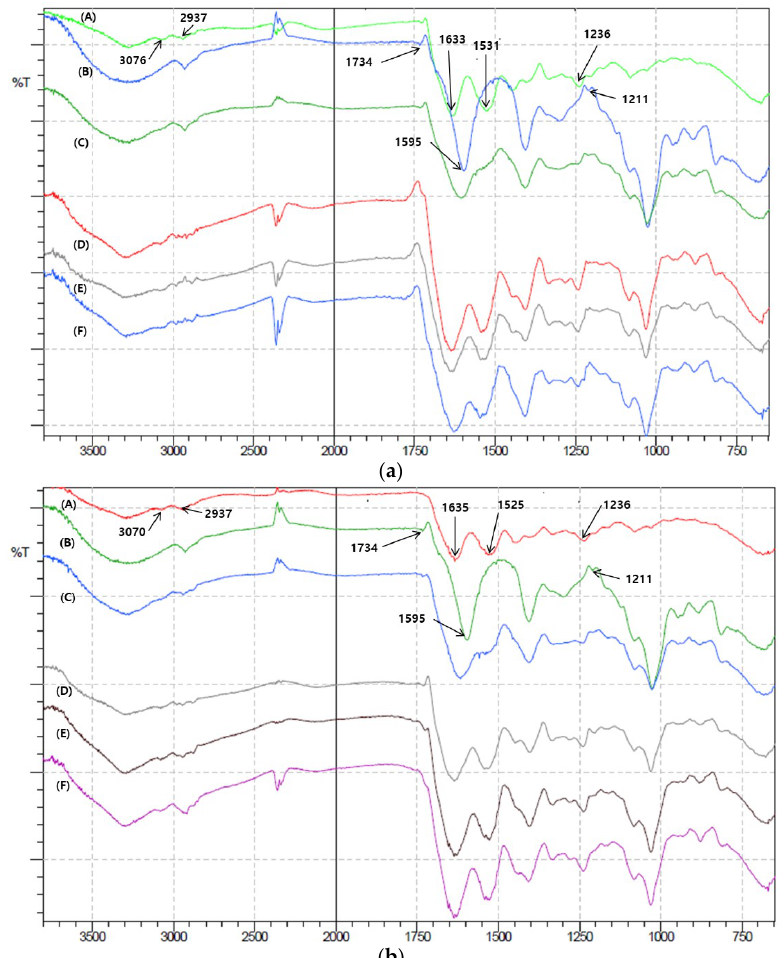
Figure 2. ATR-FTIR of various samples. ( a ) (A) Powder HWGA, (B) powder SA, (C) physical mixture of powder HWGA and SA (1:0.4), (D) freeze-dried HWGA-SA (1:0.4) solution, (E) freeze-dried HWGA-SA (1:0.4) coacervates, (F) freeze-dried HWGA-SA (1:0.4) precipitates. ( b ) (A) Powder LWGA, (B) powder SA, (C) physical mixture of powder LWGA and SA, (D) freeze-dried LWGA-SA (1:0.4) solution, (E) freeze-dried LWGA-SA (1:0.4) coacervates, (F) freeze-dried LWGA-SA (1:0.4) precipitates.